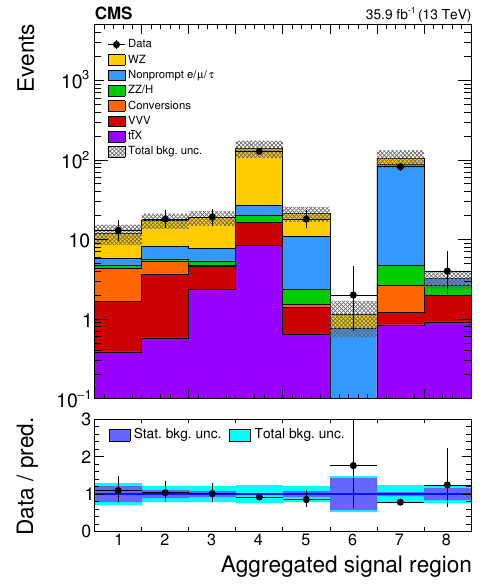
Figure 13 . Expected and observed yields comparison in the aggregated signal regions. In this plot, the charge misidenti(cid:12)cation background prediction from control samples in data (that is only relevant in the (cid:12)rst two bins due to the SS dilepton (cid:12)nal state) are included in the nonprompt background